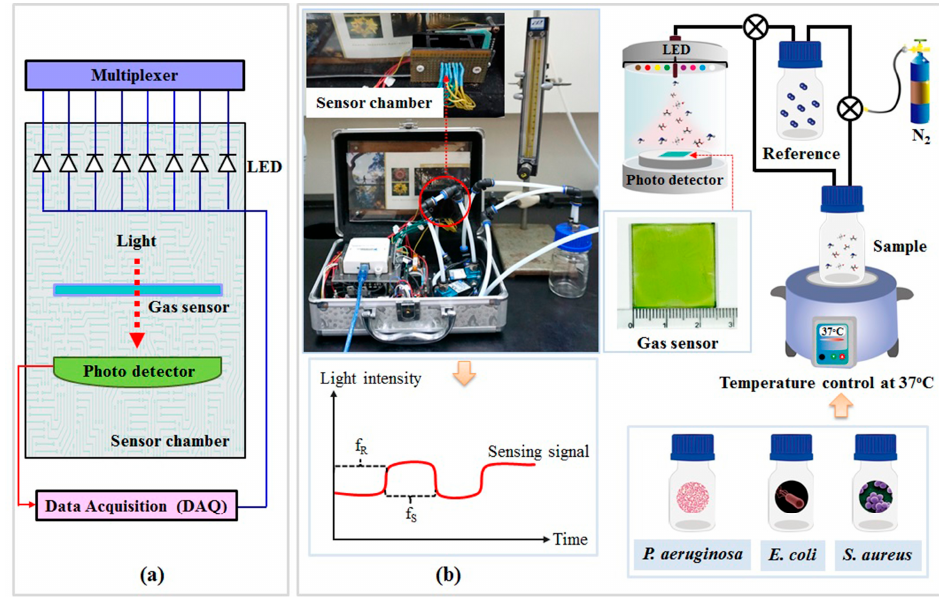
Figure 1. Schematic diagram of the optical artificial nose system, including ( a ) measurement/controller circuit section and ( b ) odor delivery section.